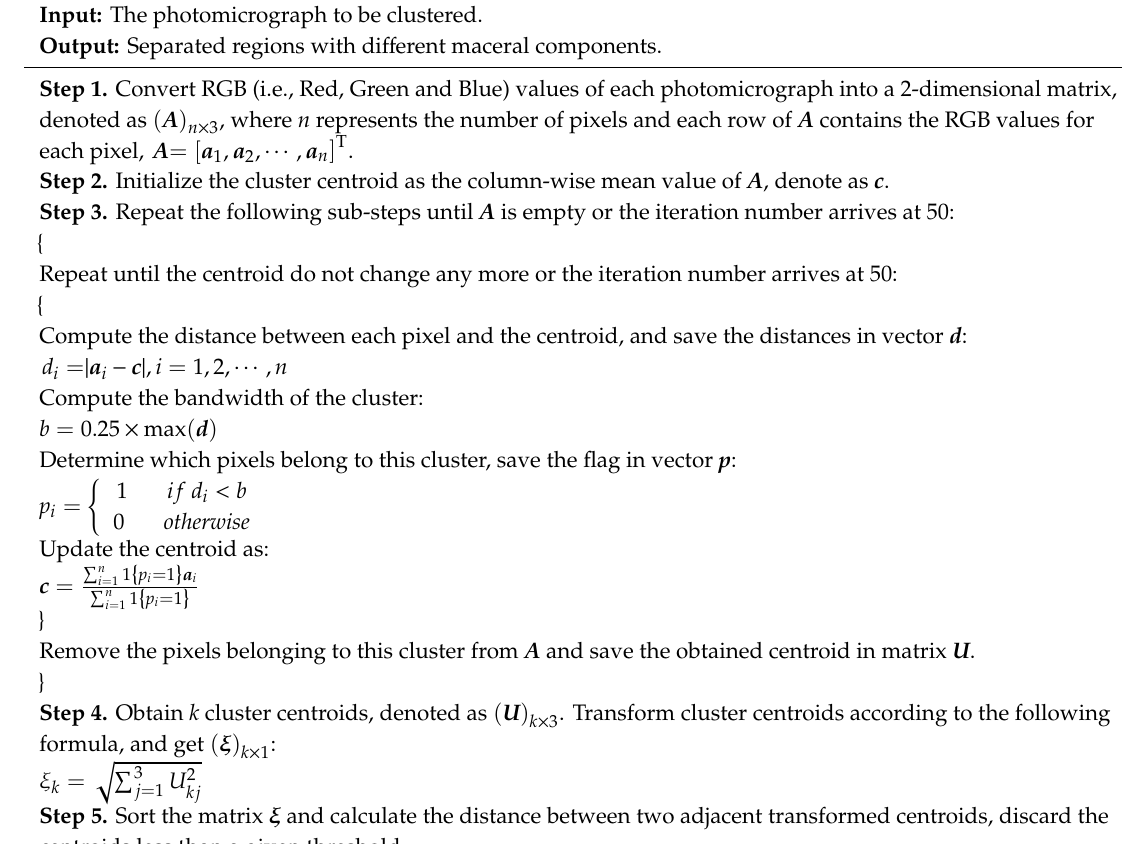
Algorithm 1. Pseudo code of the adaptive K-means clustering for image segmentation. Algorithm: Image segmentation based on adaptive K-means